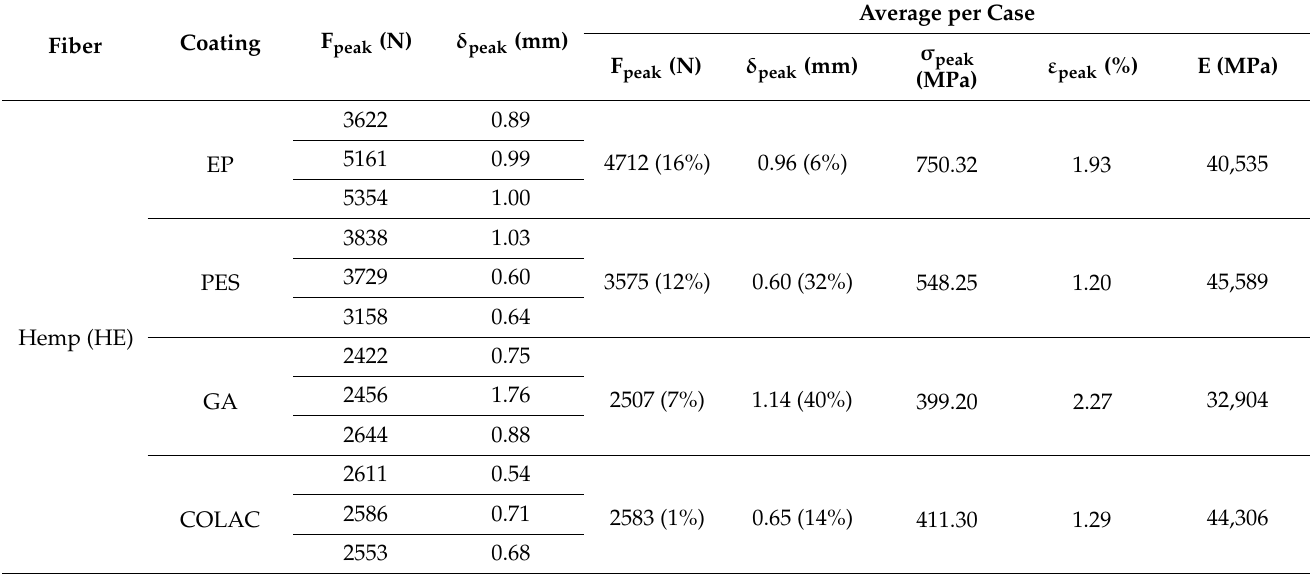
Table 8. Hemp meshes’ tensile test